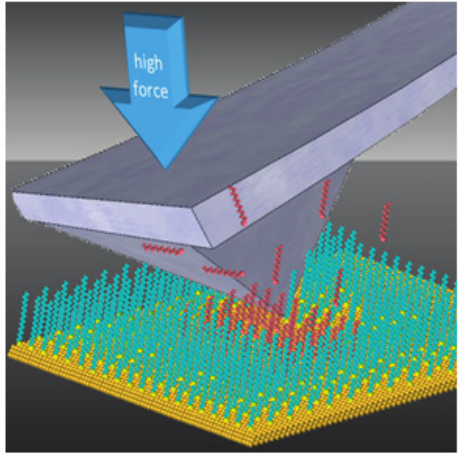
Figure 8. Operation of an AFM probe under force to accomplish